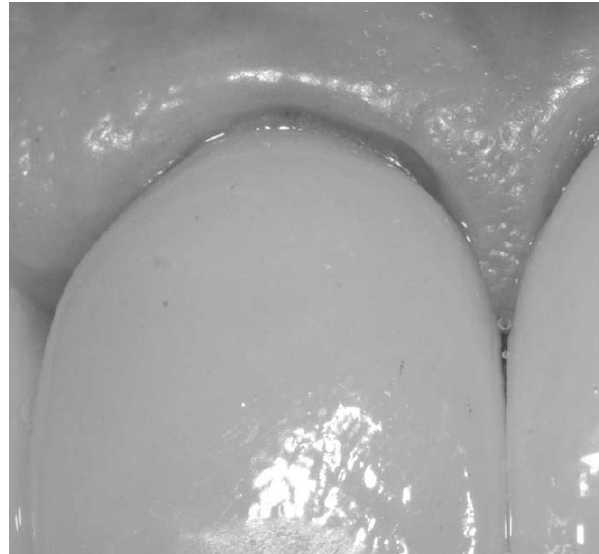
Figure 3 - Poor gingival response at the 1-year